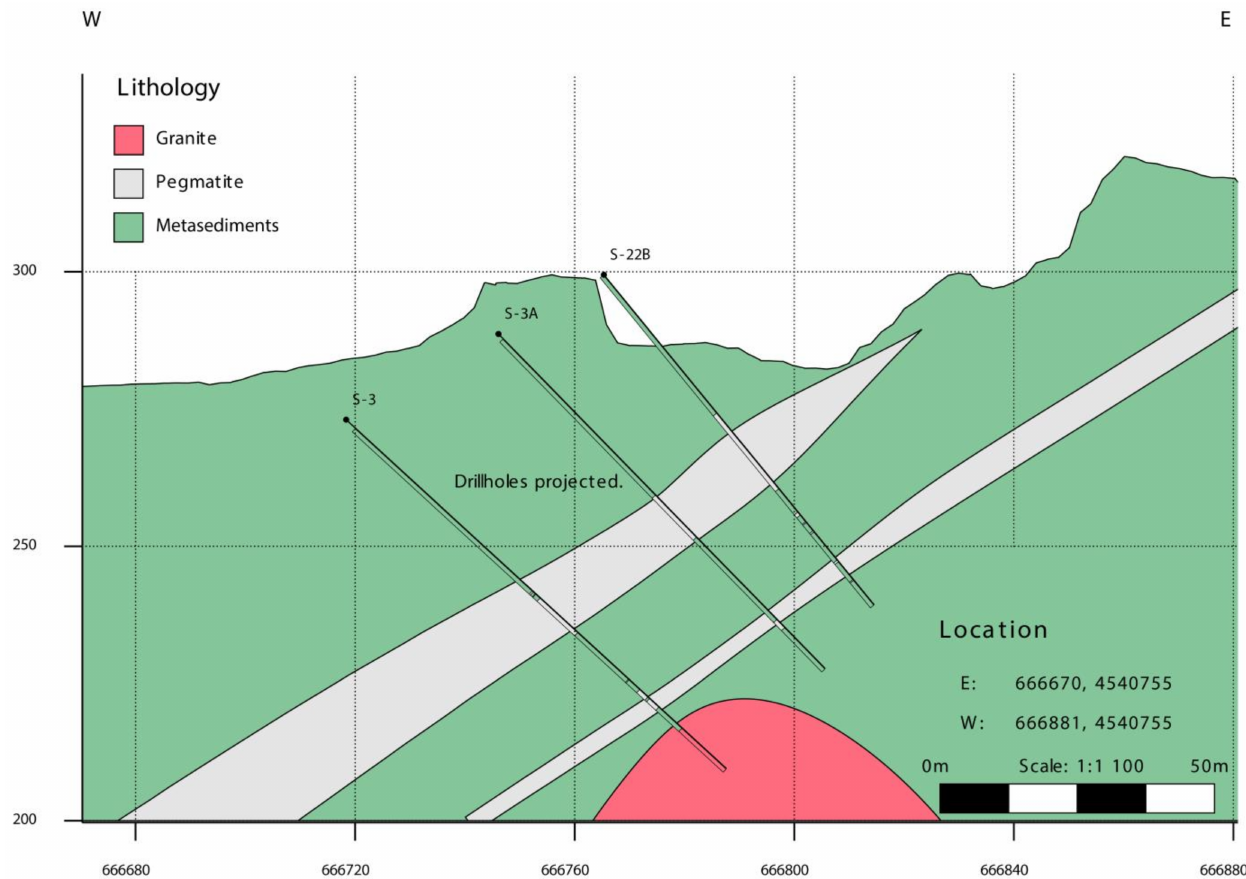
Figure 2. Geological profile of Bajoca Mine featuring Li-bearing pegmatite dykes with spatial relation to a granitic body hosted within metasedimentary rocks. The Li mineralisation is heterogeneously distributed within the dykes, since there is no internal zoning [13], while Sn mineralisation is concentrated along the aplite–pegmatite contact borders. The drillholes are projected in the profile, each one presenting variable directions and dips (from N115 ◦ E to N118 ◦ E; 39 ◦ to 45 ◦ S for S3; N125 ◦ E; 40 ◦ to 45 ◦ S for S3A; and from N124 ◦ E to N127 ◦ E; 41 ◦ to 45 ◦ S for